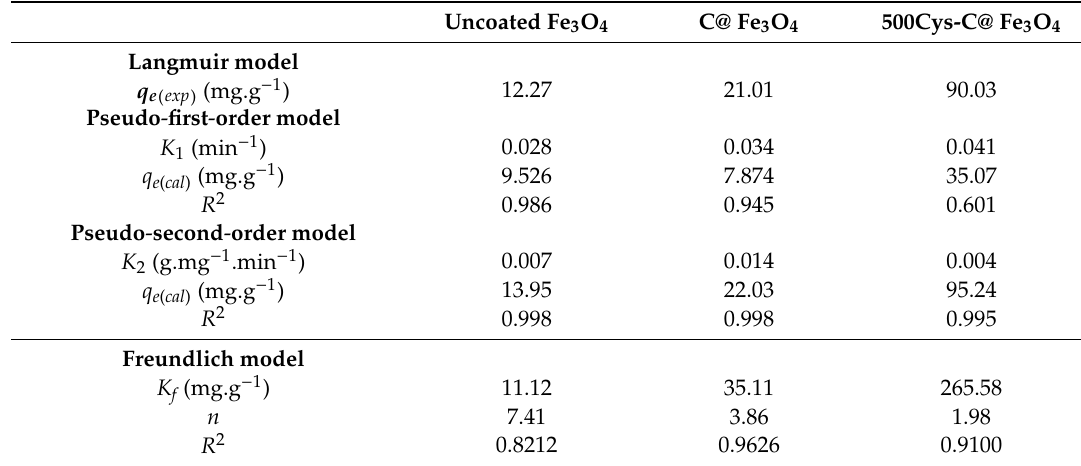
Table 2. Adsorption isotherm parameters and sorption rate constants for Hg(II) adsorbed on